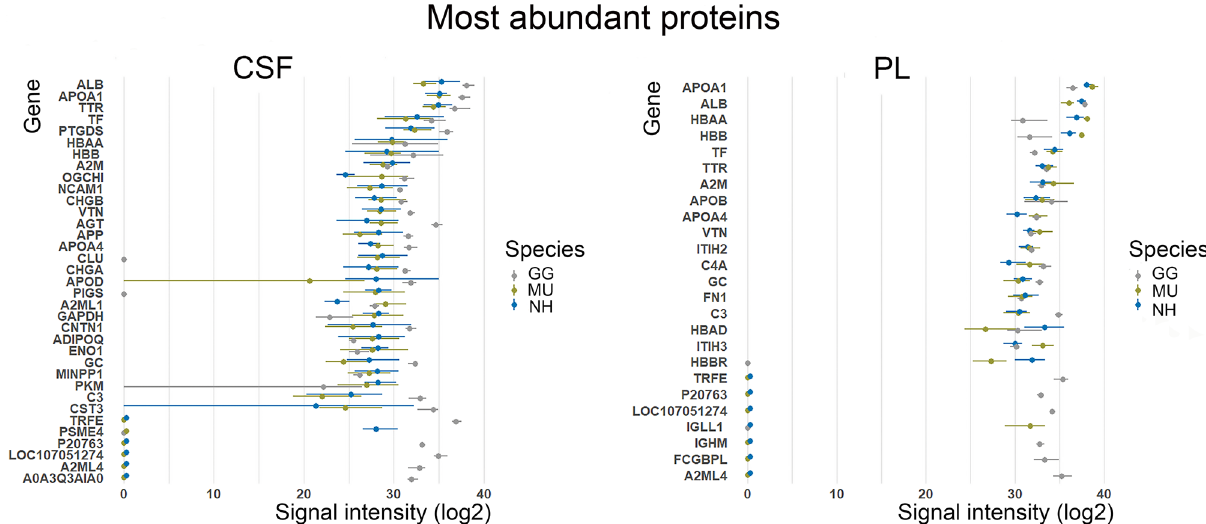
Figure 3. The top 2% most abundant cerebrospinal fluid (CSF) and plasma (PL) proteins of chicken (GG), budgerigar (MU) and cockatiel (NH) are presented using their gene code: GG—grey, MU—green and NH—blue. The logarithmic normalised abundances are shown as a range (minimum–maximum) across all individuals (GG n = 7, MU n = 5, NH n = 5) with a mean highlighted as a dot (R version 4.0.0, www.r-proje